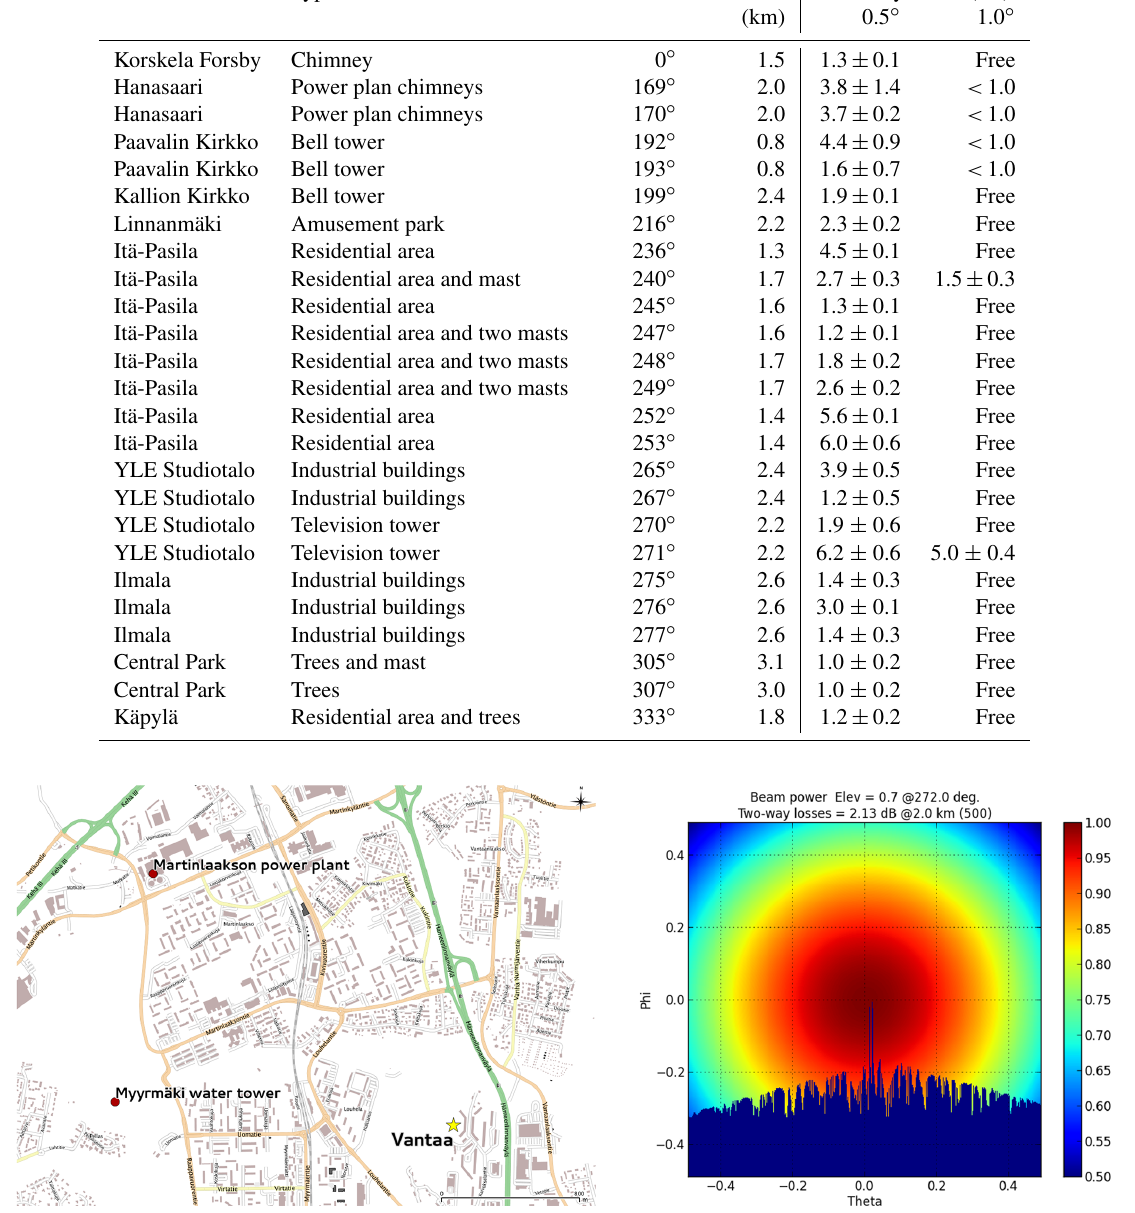
Figure 6. Left: Vantaa radar and Myyrmäki water tower. Right: estimated radar beam blocking at 0.7 ◦ elevation and 272 ◦ azimuth. Color represents the beam power normalized to one in the beam